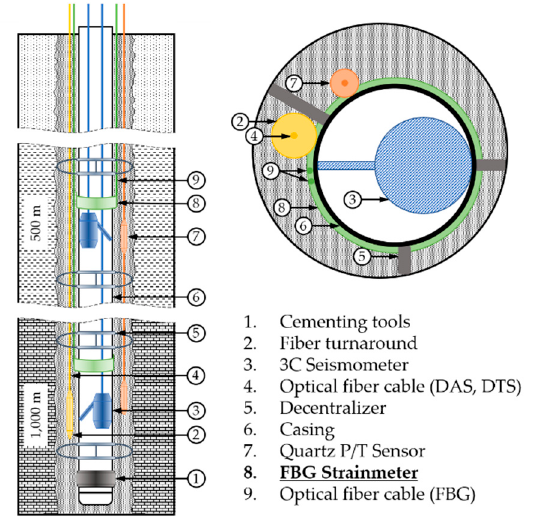
Figure 1. Monitoring borehole design at TELLUS project.